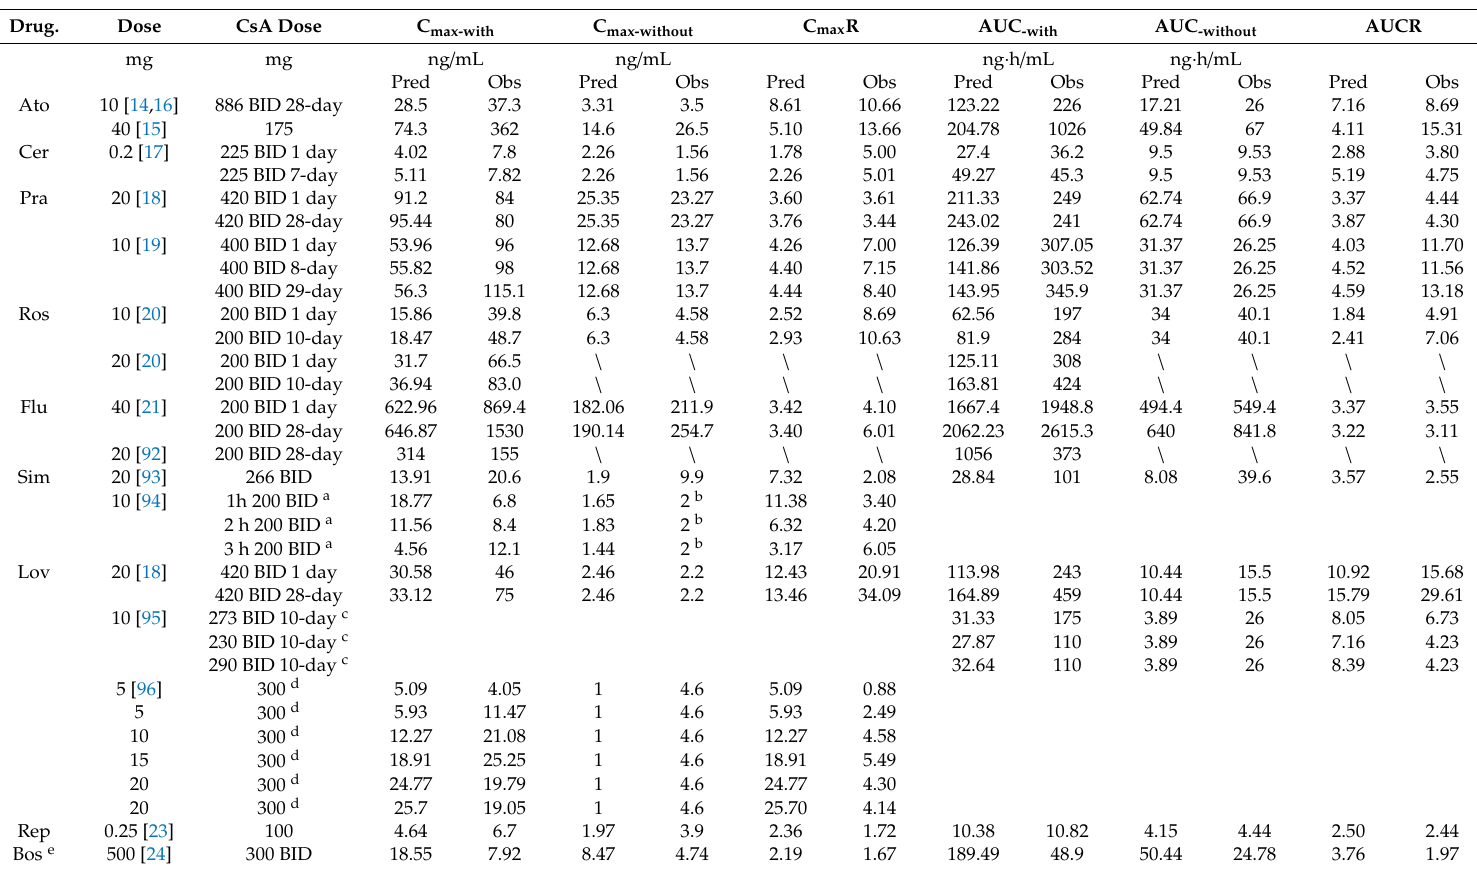
Table 6. The predicted (Pred) pharmacokinetic parameters and the mean clinic observations (Obs) of atorvastatin (Ato), cerivastatin (Cer), pravastatin (Pra), rosuvastatin (Ros), fluvastatin (Flu), simvastatin (Sim), lovastatin (Lov), repaglinide (Rep) and bosentan (Bos) combined with cyclosporine (CsA).